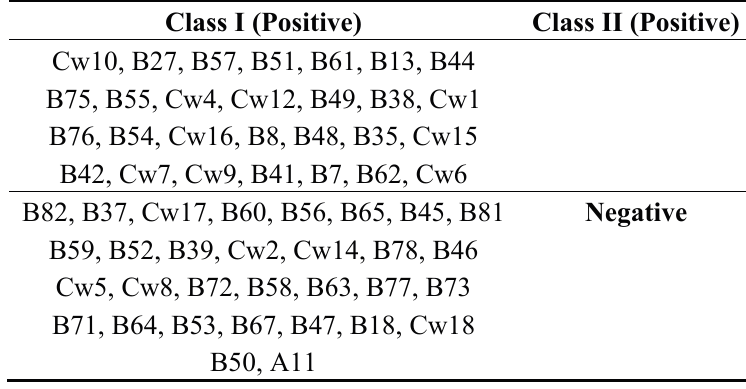
Table 1. MHC class I molecules, not class II molecules, bind to BH2. The results were summarized from Figure